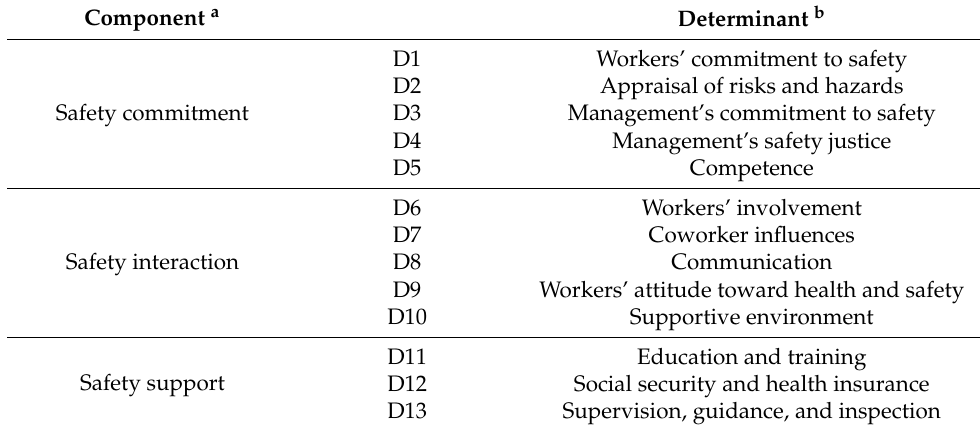
Table 1. Components and determinants of the safety climate in construction sites of Saudi Arabia.